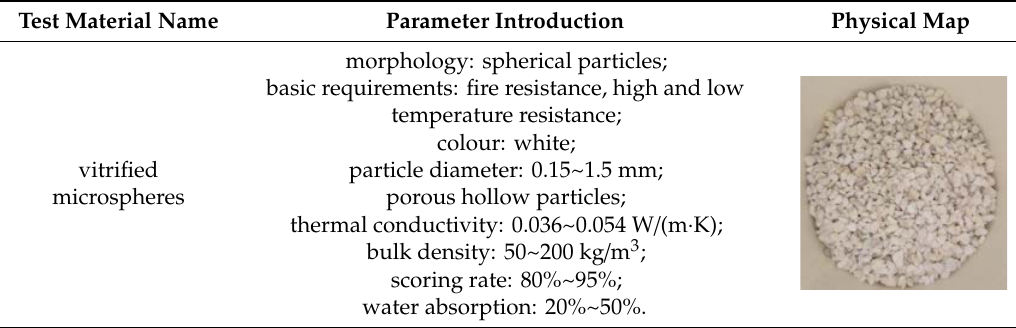
Table 4. Vitrified microspheres basic parameter table.